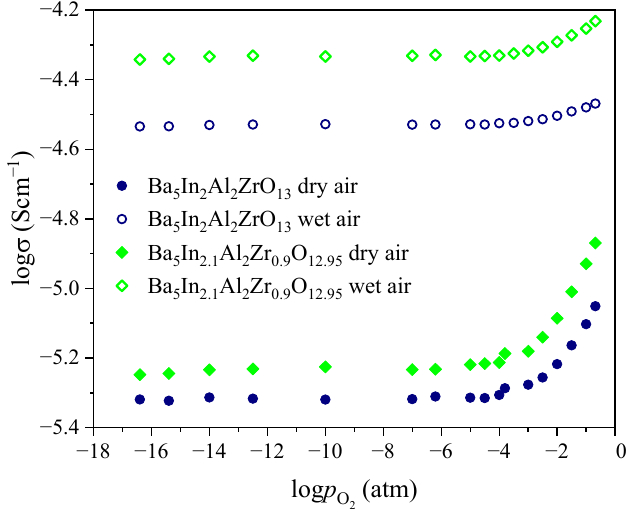
Figure 11. Oxygen partial pressure dependence of total conductivity at 500 ◦ C in dry ( p H 2 O = 3.5 · 10 − 5 atm) and wet ( p H 2 O = 1.92 · 10 − 2 atm) atmospheres for Ba 5 In 2 Al 2 ZrO 13 and Ba 5 In 2.1 Al 2 Zr 0.9 O 12.95 .